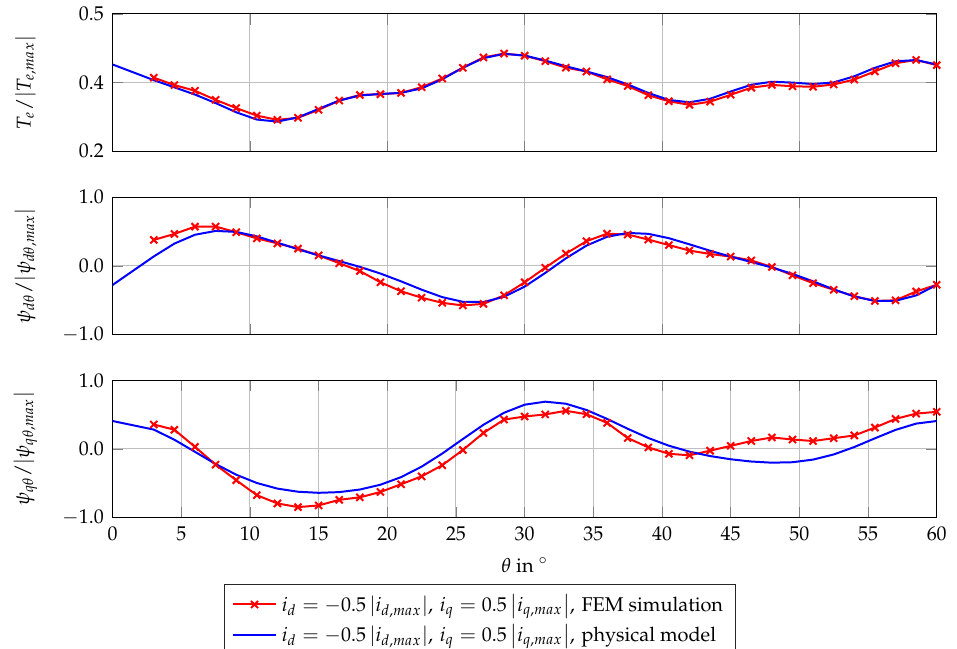
Figure 3. Comparison between the calibrated surrogate model from Section 2.3 and the accurate numerical finite element method (FEM)